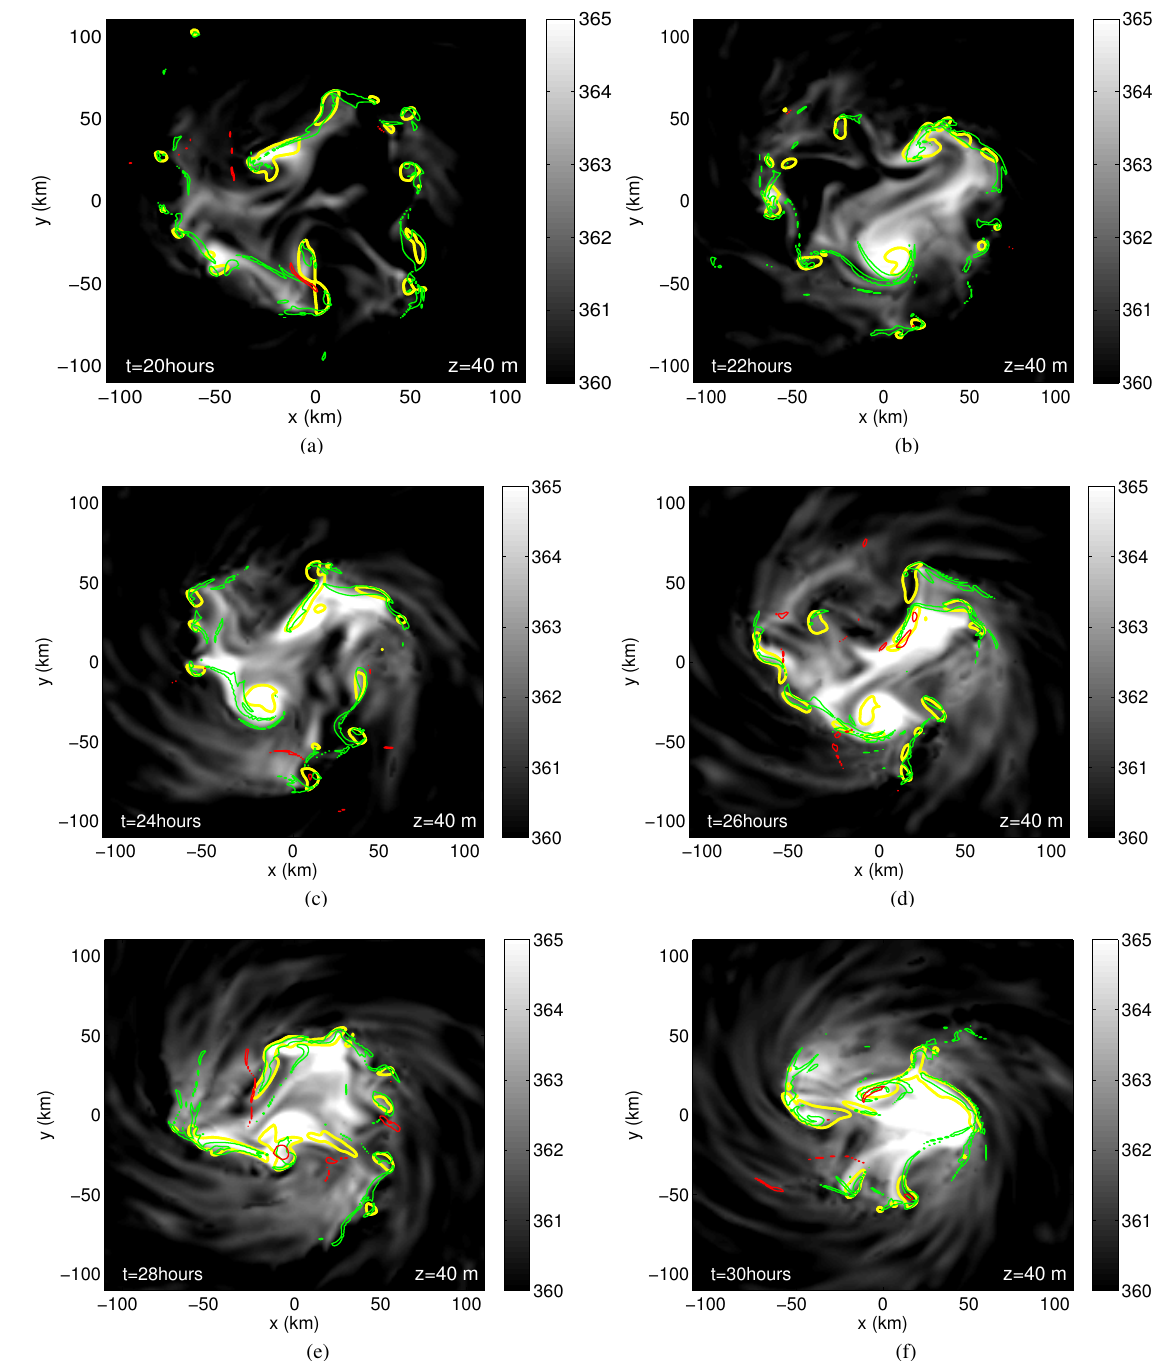
Fig. 13. Attracting (green) and repelling (red) Ψ 22 ridges and vorticity contours (yellow) are overlaid on θ e fields with 1 hour integration time at times from 20 hours to 30 hours every 2 hours at the bottom of the boundary layer.